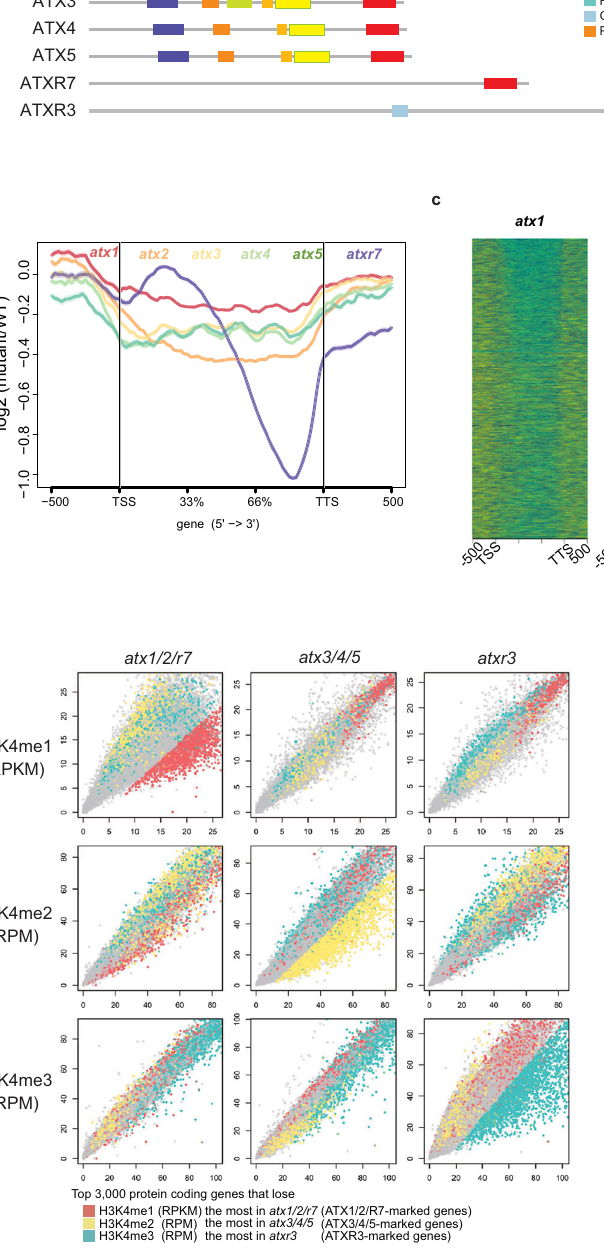
Expectednumberofintersections;n=328Top3,000proteincodinggenesthatlose (ATX1/2/R7-markedgenes) (ATXR3-markedgenes)H3K4me1(RPKM) (ATX3/4/5-markedgenes) H3K4me2 (RPM) population(allprotein-codinggenes);n=27,409 H3K4me3 (RPM) Fig. 1 | ATX1, ATX2 , and ATXR7 redundantly contribute to H3K4me1. a Domain respectively. Values for H3K4me2/3 are RPM normalized instead of RPKM as in architectures of ATX(R) proteins from the UniProt database. b Metaplot illustrates H3K4me1 because unlike H3K4me1, which covers the gene body, the amounts of the averaged pattern of H3K4me1 changes of the 6 mutants compared to WT. H3K4me2andH3K4me3arelessdependentongenelength 10 . e Westernblottingof c Mutations of atx1 , atx2 , and atxr7 synergistically cause reduced H3K4me1 in the H3K4 methylations on bulk histone extracted from the mutants. The atx1/2/r7 mutant on the right consists ofthree T-DNA alleles thatare different from those in gene body. H3K4me1 changes from WT are visualized as heat maps. All genes are ordered so that genes that lost H3K4me1 the most in atx1/2/r7 come to the top. atx1/2/r7 mutantmainlyusedinthisstudy.WesternblottingforH3K4me1in atx1/2/ d ChIP-seq for H3Kme1, H3K4me2, and H3K4me3 in mutants ( y -axis) compared to r7 wererepeated and quanti fi ed (Supplementary Fig. 2a). f Activities of ATX1/2/R7, ATX3/4/5, and ATXR3 are observed in mutually exclusive genes. All pairwise ATX1/ WT ( x -axis). Each dot represents each gene. Axes are trimmed to 0.98 quantiles. 2/R7-marked genes, ATX3/4/5-marked genes, and ATXR3-marked genes have sig- Top genes ( n =3000) that lose H3K4me1 most in atx1/2/r7 (hereafter ATX1/2/R7- ni fi cantly fewer overlaps than expected ( n =328). Signi fi cances of the under- marked genes), lose H3K4me2 in atx3/4/5 (ATX3/4/5-marked genes), and lose representation are tested by hypergeometric tests ( p <1e-4 for all H3K4me3 in atxr3 (ATXR3-marked genes) are colored red, yellow, and blue,